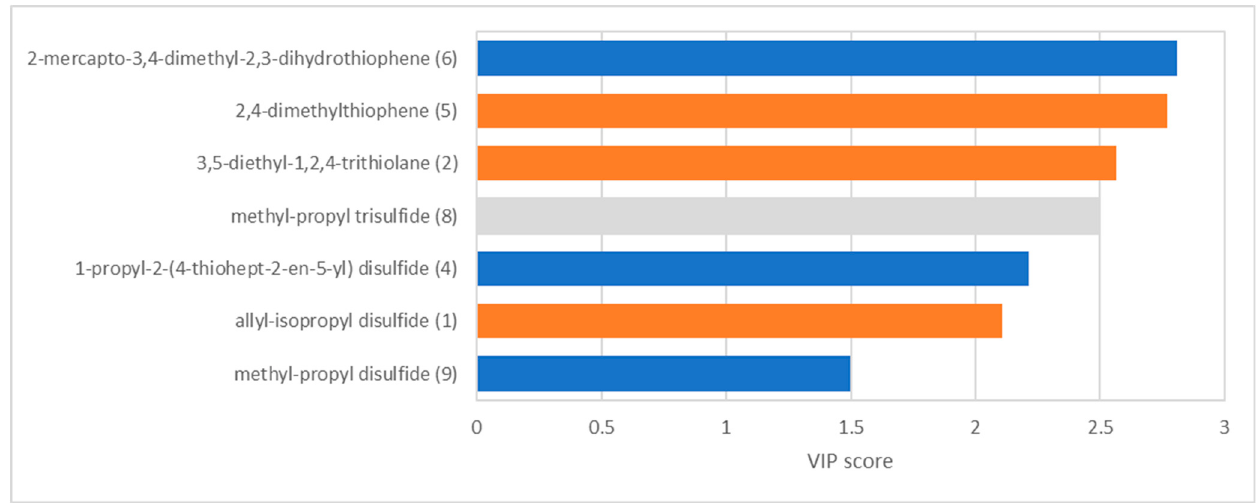
Figure 2. Variables important for the projection (VIP) values from Kruskal test on PLS-DA model. Upregulated com- pounds = orange bars; downregulated compounds = blue bars; unregulated compounds = grey bars.